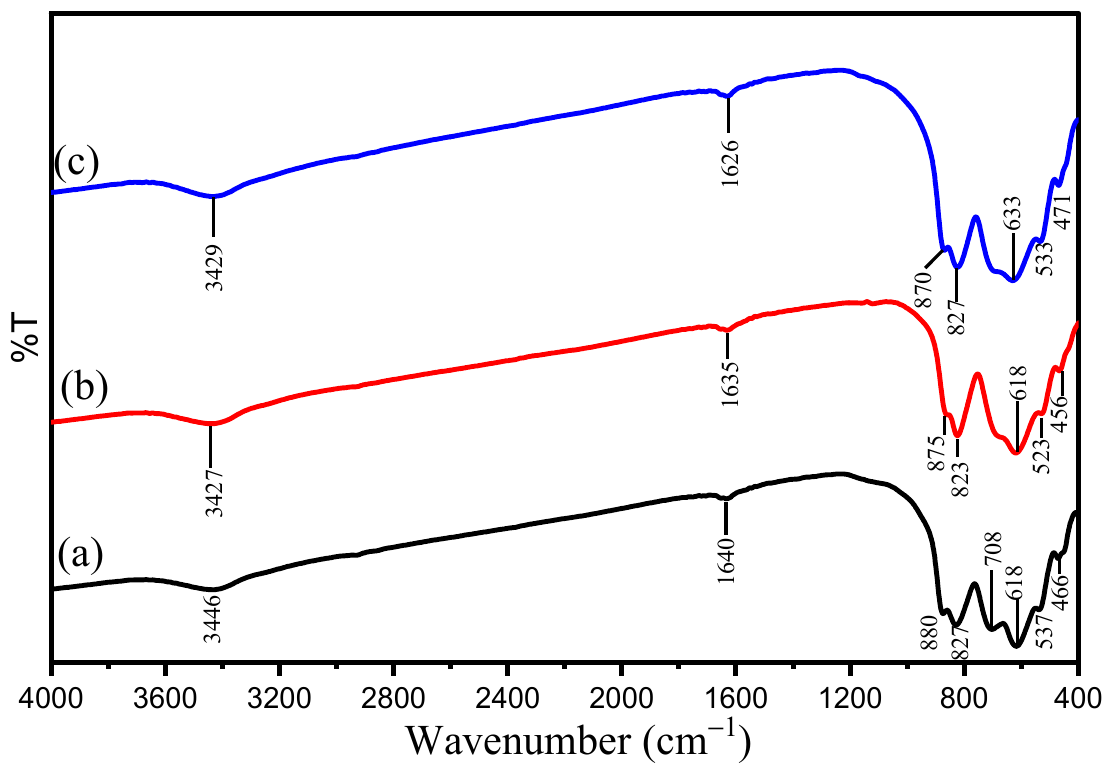
Figure 1. FTIR spectra of ( a ) NiWO 4 ( b ) CoWO 4 and ( c ) mix metal tungstate NiWO 4 /CoWO 4 NC.